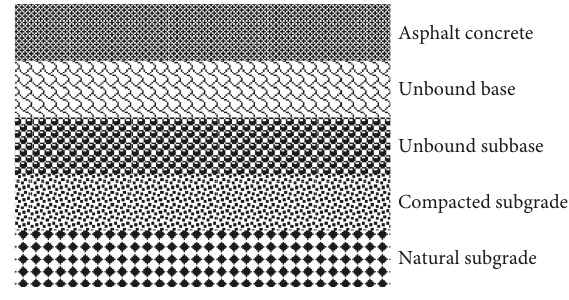
Figure 7: A typical cross section of flexible pavement. Table 7: Material properties and pavement layer thicknesses.